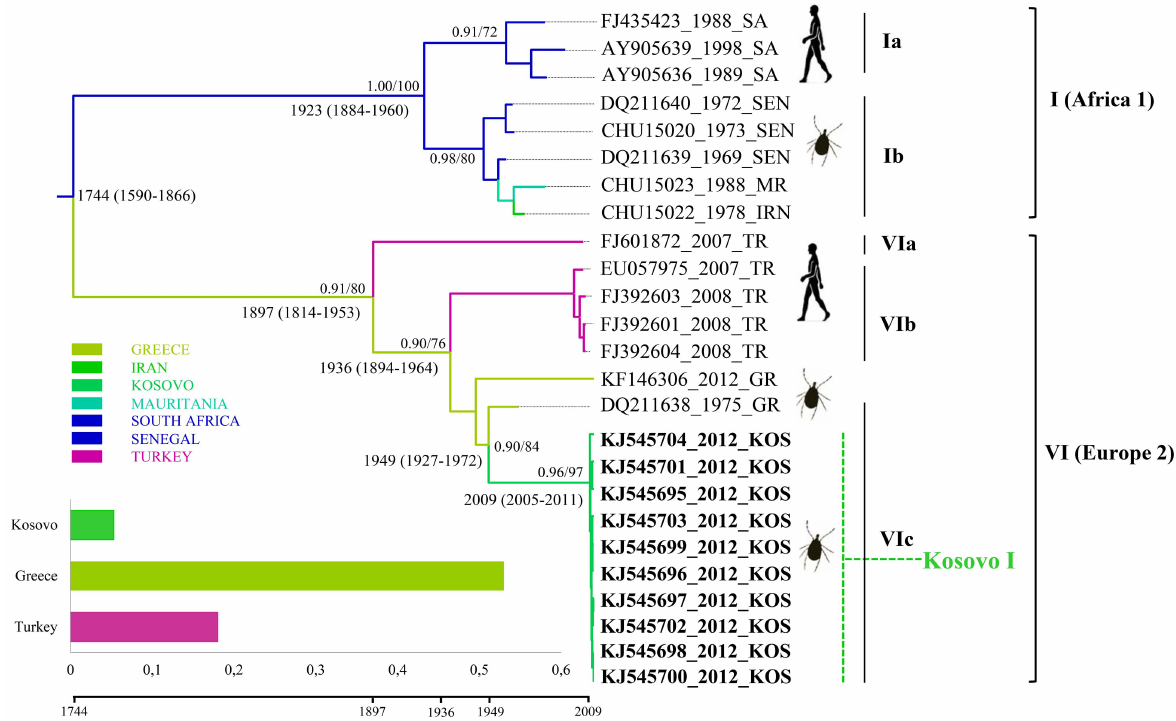
Figure 3. Enlargement of the section of MCC tree containing Kosovar lineage I. The estimated dates of divergence from neighbouring sister lineages and mean dates of existence for the most recent common ancestor (MRCA) for lineage containing Kosovar sequences (with 95% HPD in parentheses) are shown at the relevant nodes. The branches are coloured on the basis of the most probable location of the descendent nodes (GR, Greece; IRN, Iran; KOS, Kosovo; MR, Mauritania; SA, South Africa; SEN, Senegal; TR, Turkey). Histogram insertions indicate the location state probabilities for the estimated introductions of CCHFV that gave rise to Kosovo lineage I. Taxon labels include accession number, year of isolation, and country of origin. The human and tick-derived CCFHV strains are also indicated. Tick-derived sequences generated in this study are bolded (clade ‘‘Kosovo I’’).